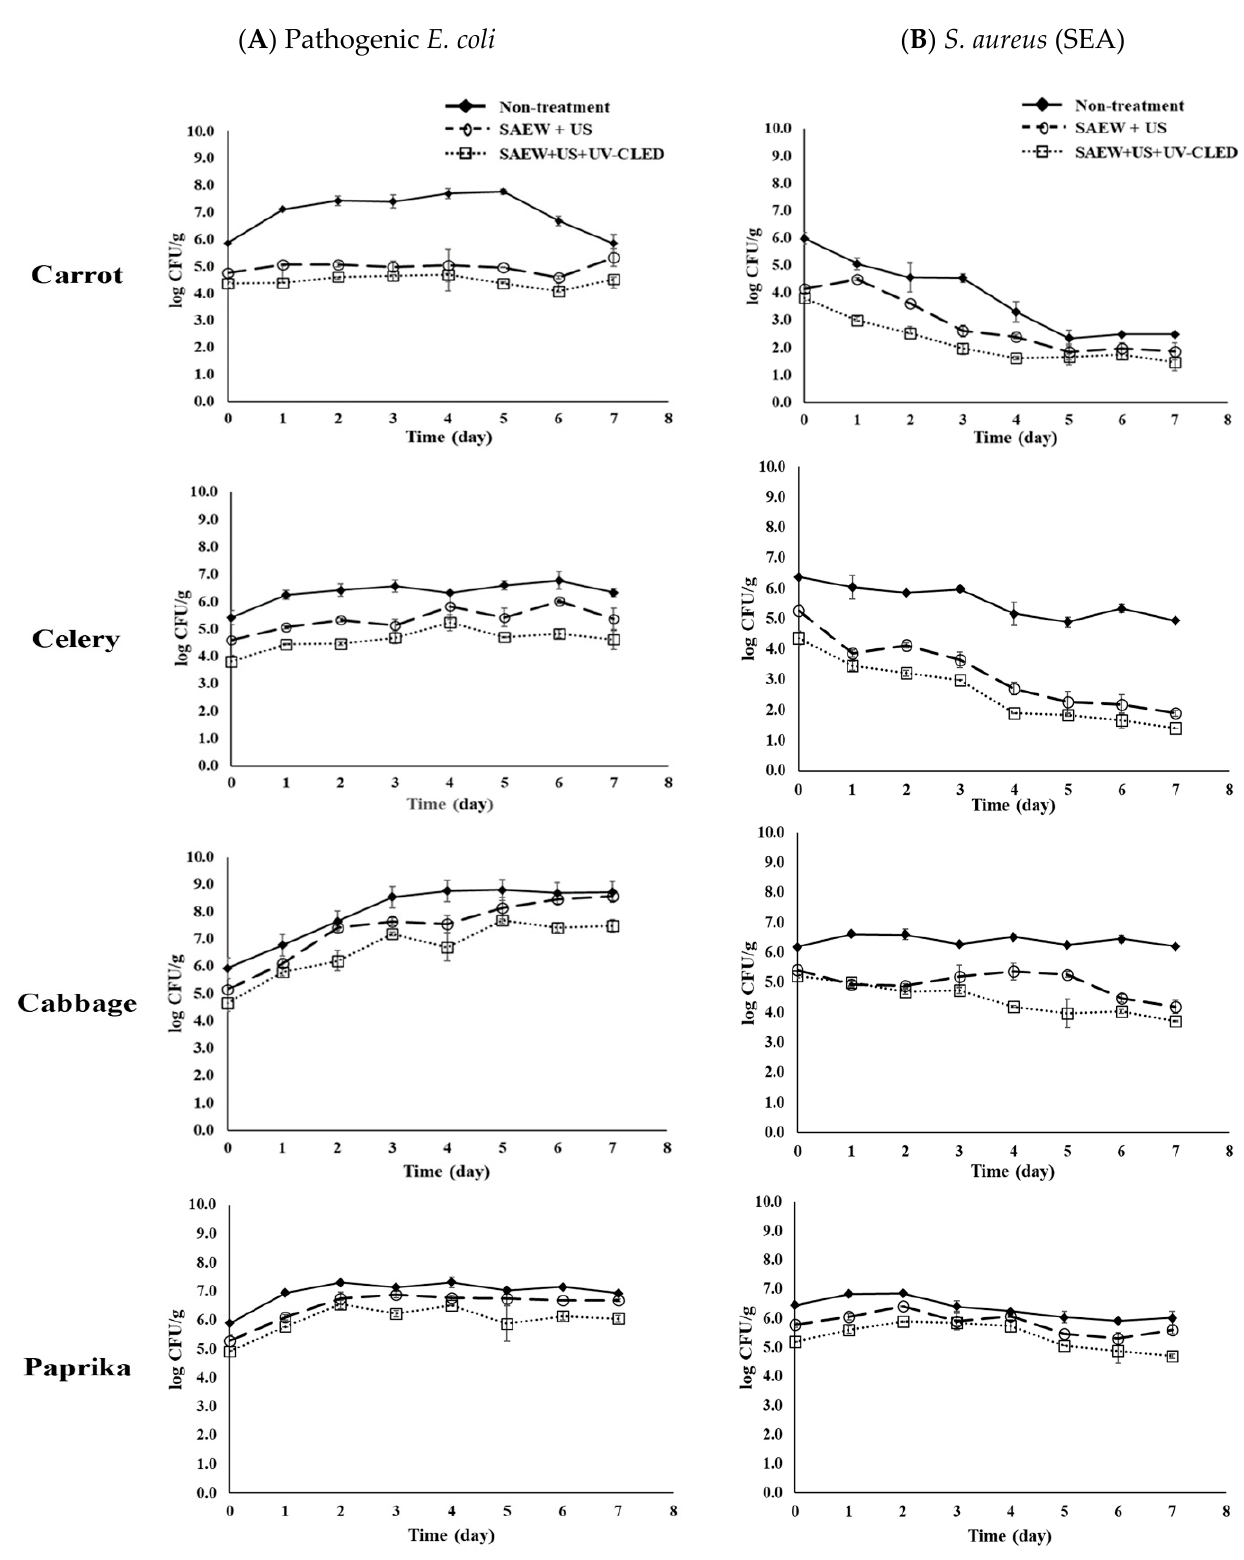
Figure 3. Effect of combined treatment on the survival of ( A ) pathogenic E. coli (cocktail of EPEC, ETEC, and E. coli O157:H7) and ( B ) S. aureus (SEA) in fresh-cut carrot, celery, cabbage and paprika stored for 7 days at 15 °C. Non-treatment, no extra wash with a sanitizer; SAEW, slightly acidic electrolyzed water; US, ultrasounds; UV-C LED, ultraviolet-C light-emitting diodes (275 nm); the data were obtained from a selective media.